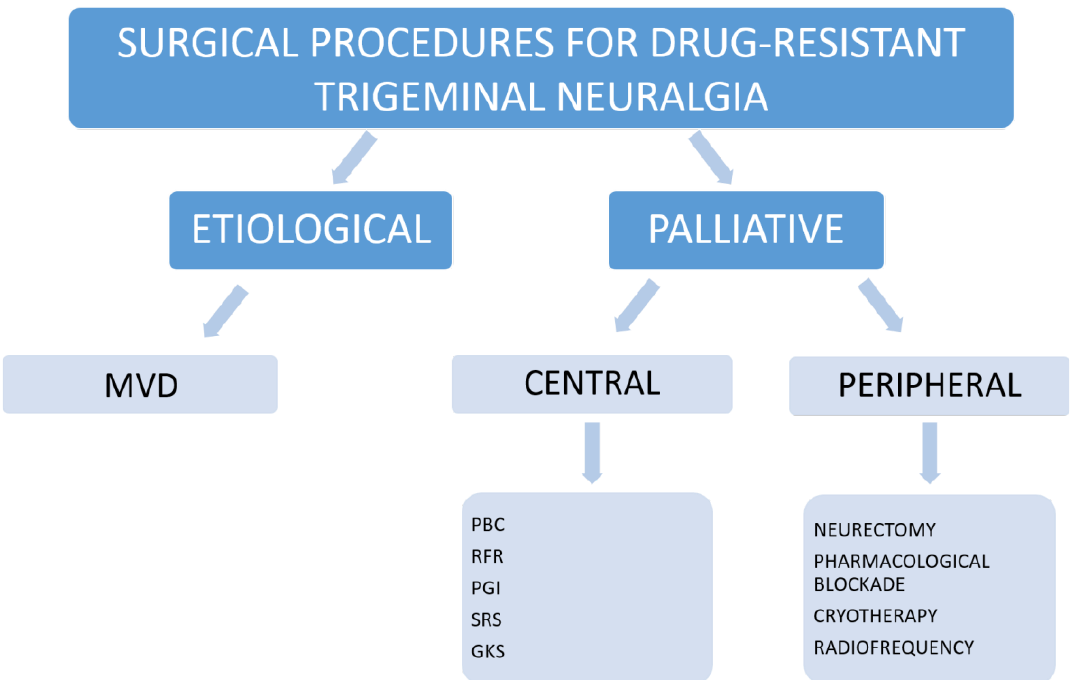
Figure 2. Summary of the available surgical procedures for the treatment of drug-resistant TN.